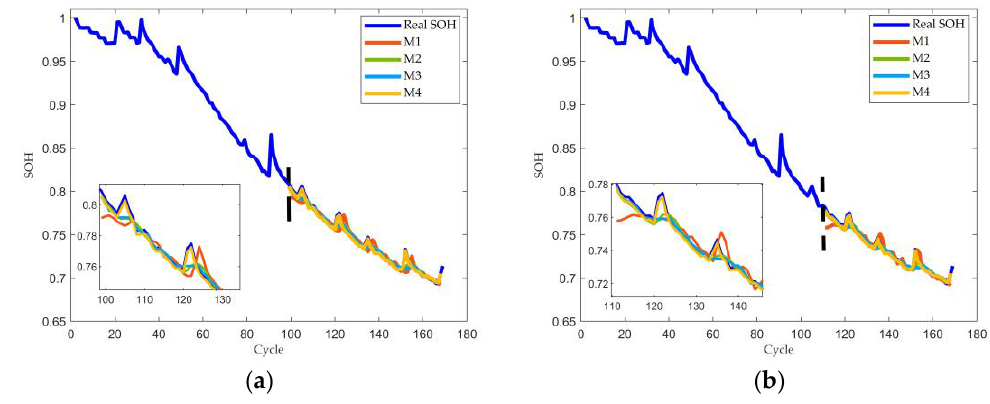
Figure 11. SOH prediction results for B0005 at different SPs. ( a ) SP = 80%; ( b ) SP = 90%. RMSE, MAE, and MAPE have been adopted as error evaluation metrics to quantita- tively assess the accuracy of the CNN-BiLSTM-AM prediction model. Table 5 illustrates the prediction results of SOH based on different models for batteries B0005, B0006, and B0018 with different SPs. In Table 5, the smallest RMSE, MAE, and MAPE are 0.00487, 0.00307, and 0.420%, respectively, corresponding to the M4 model for the B0005 battery at SP = 90%; the largest RMSE, MAE, and MAPE are 0.0153, 0.0121, and 1.60%, respectively, corresponding to the M1 model for the B0018 battery at SP = 90%. While the magnitude of the capacity rebound portion of the B0018 battery is larger, the M4 model is also accurately validated. The error of the M4 model for all three batteries are lower than the comparison models, with RMSE lower than 0.0120, MAE lower than 0.007, and MAPE lower than 0.9%. According to the results, the M4 model has the highest accuracy and the lowest prediction error. Table 5. Prediction results of SOH based on different models for batteries B0005, B0006, and B0018 with different SPs. Battery Prediction SP Model RMSE MAE MAPE (%) M1 87 (70%)